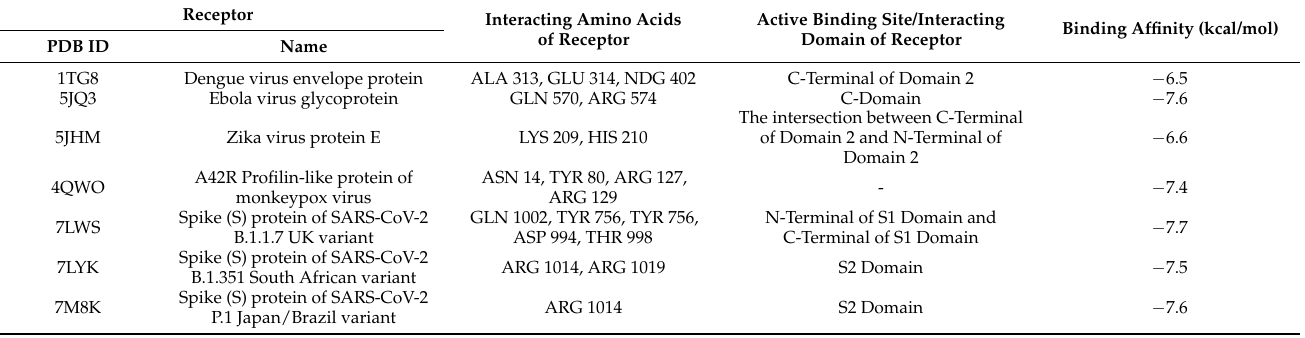
Table 10. Molecular docking analysis of andrographolide (CID: 5318517) derived from A. paniculata . Receptor Interacting Amino Acids Active Binding Site/Interacting Binding Affinity (kcal/mol) of Receptor Domain of Receptor PDB